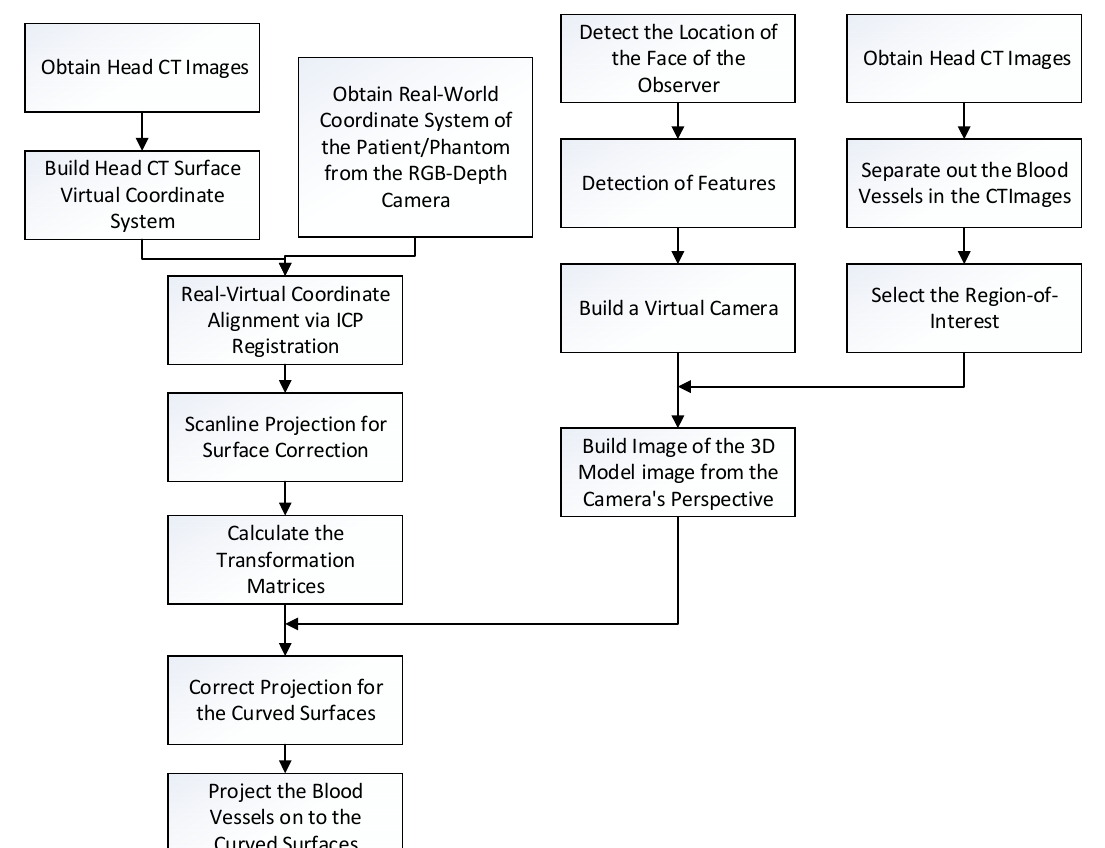
Figure 1. The flowchart of the proposed projection-based augmented reality system. Appl. Sci. 2022 , 12 , x FOR PEER REVIEW